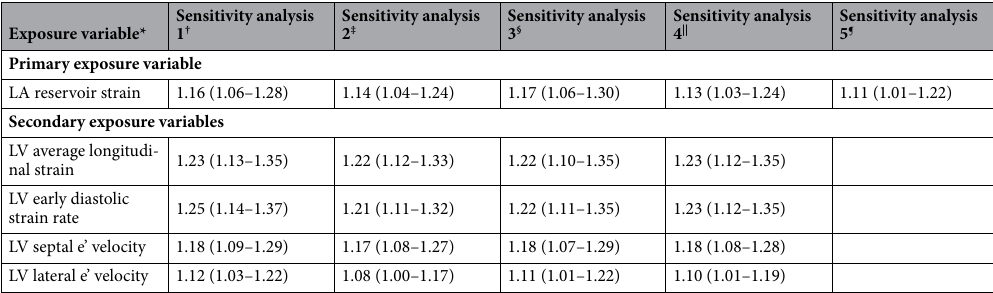
Table 3. Sensitivity analyses of associations between myocardial mechanics and incident ischemic stroke in the cardiovascular health study. LA, left atrial; LV, left ventricular. *Reported results represent the hazard ratio (95% confidence interval) for ischemic stroke per each standard deviation absolute decrease in strain and decrease in strain rate and e’ velocity. Lower absolute values represent worse strain. Reported models were adjusted for age, race, sex, study site, speckle-tracking analyst, chamber-specific echocardiogram image quality, education, body mass index, coronary heart disease, heart failure, diabetes, systolic blood pressure, anti-hypertension medication, high-density lipoprotein level, low-density lipoprotein level, log-transformed triglyceride level, smoking status, LV ejection fraction, and a time-varying covariate for atrial fibrillation. † This sensitivity analysis included only participants with echocardiograms performed at study baseline. ‡ This